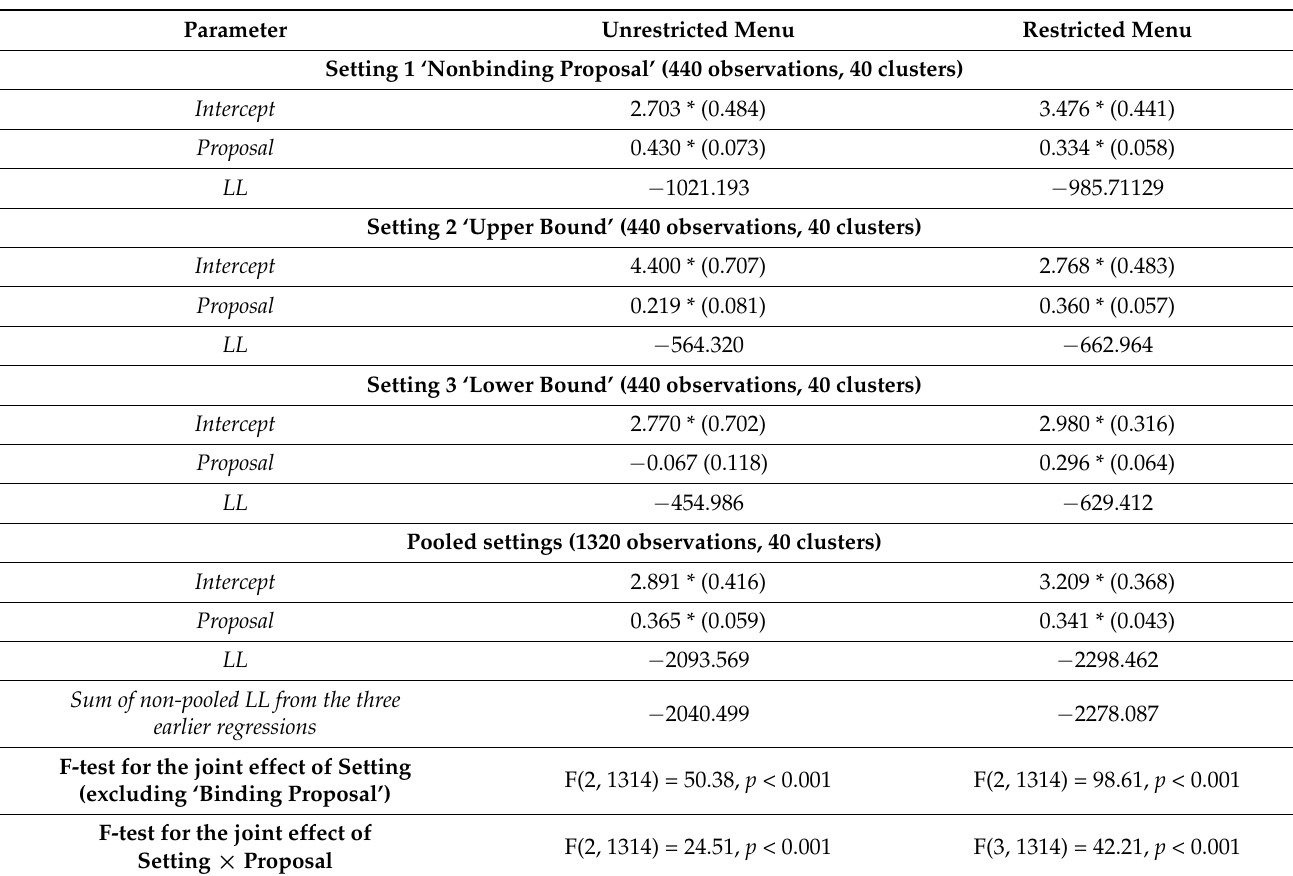
Table 5. Estimates for linear regression of agent’s response function for each of the settings (nonbind- ing proposal setting, Upper Bound, and Lower Bound) as well as pooled settings. Right and left censoring was conducted via Tobit in the Upper Bound setting and Lower Bound setting, respectively, and two-sided censoring was performed in the pooled regression. Robust standard errors (N = 40) are reported in all cases. There are 40 participants per cell, and 320 participants in